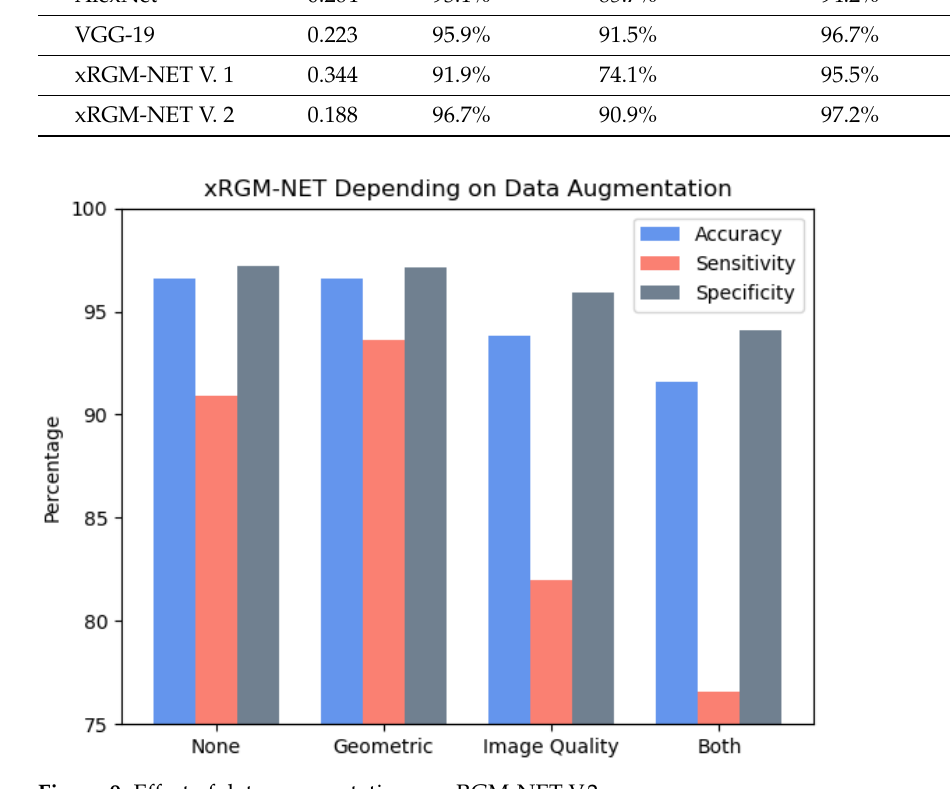
Figure 9. Effect of data augmentation on xRGM-NET V.2.